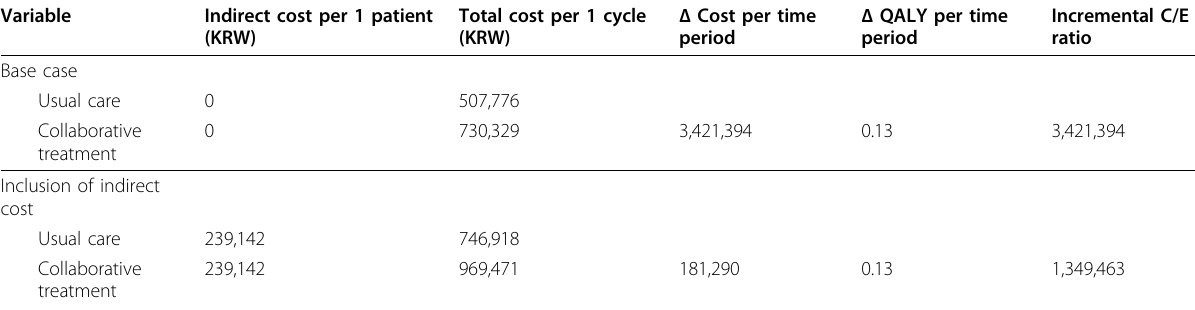
Table 7 Univariate sensitivity analysis of indirect cost (KRW in 2009)